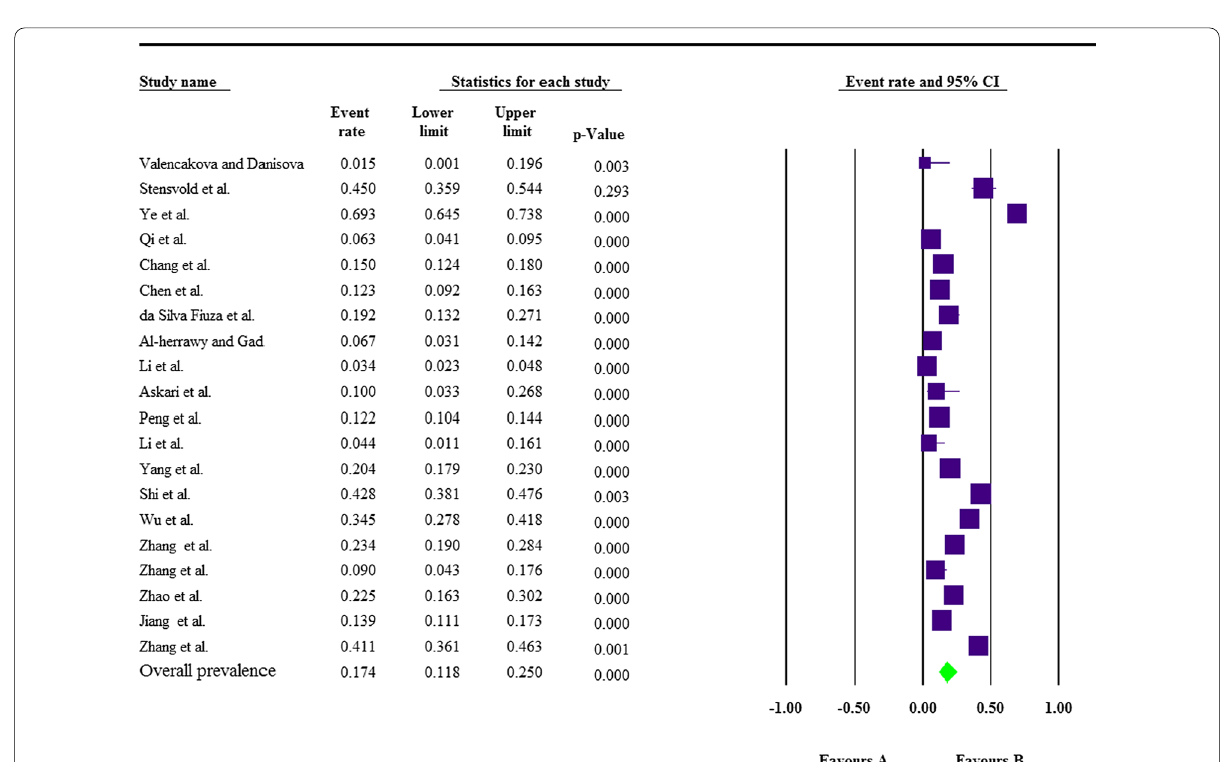
Fig. 2 The pooled molecular prevalence of E. bieneusi infection in